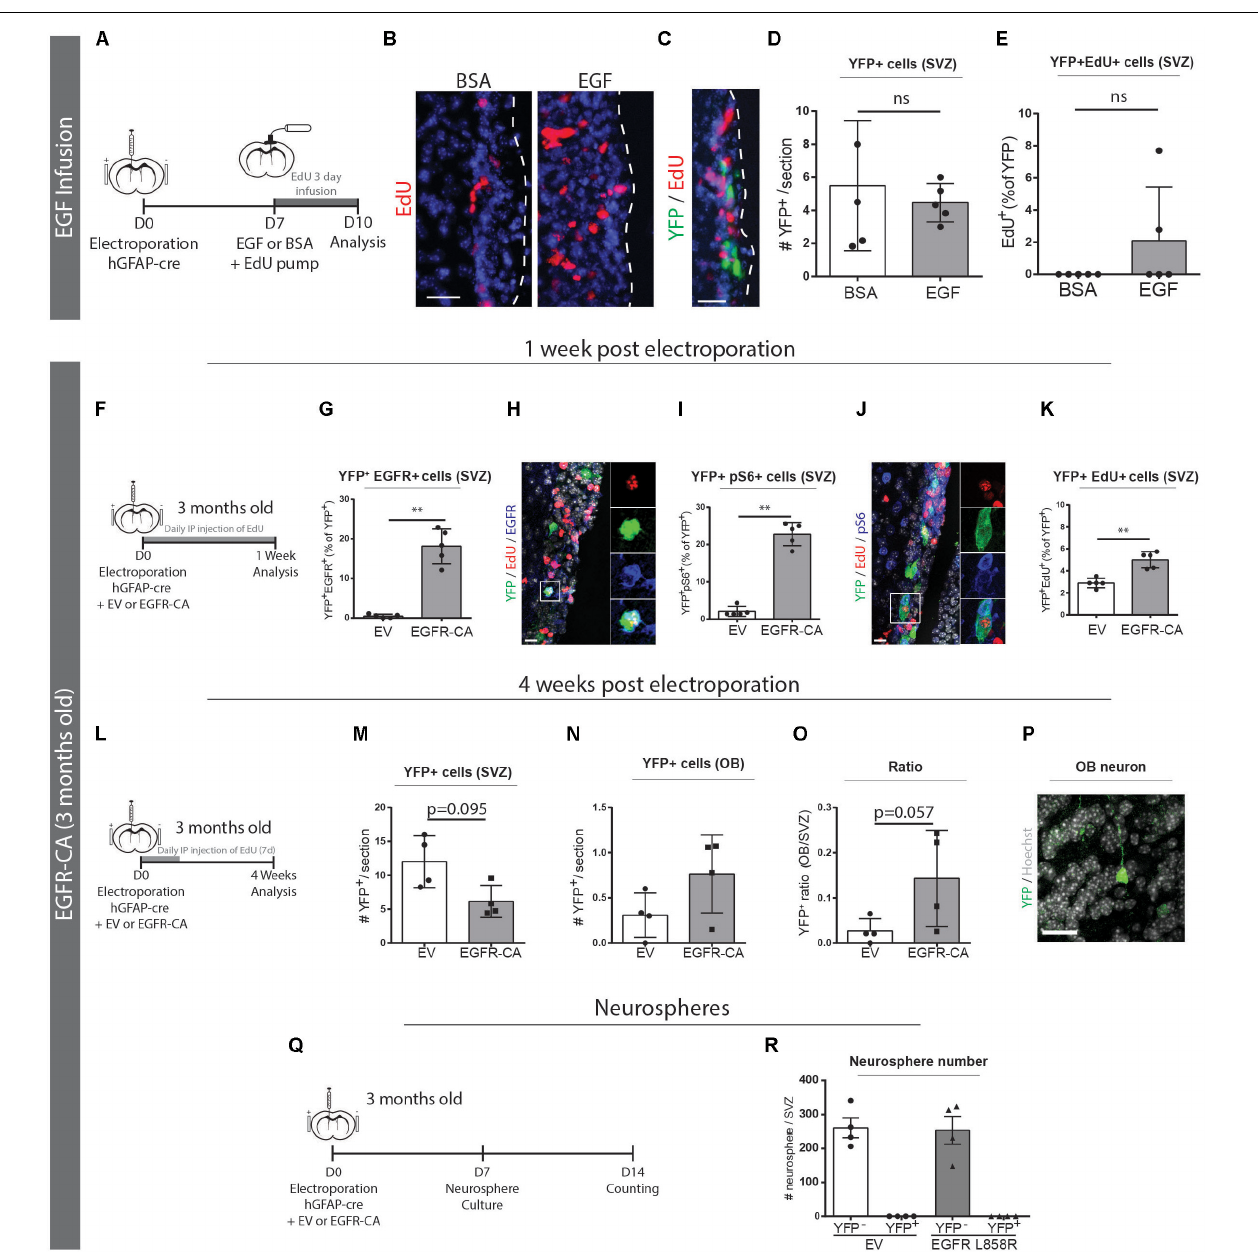
FIGURE 4 | Genetic activation of EGFR signaling can promote qNSC division in vivo . (A–E) Electroporated GFAP + qNSCs do not divide in response to EGF infusion. (A) Paradigm for adult brain electroporation with hGFAP-cre plasmids in Rosa26-stop-EYFP reporter mice followed by 3 days infusion of EdU with either EGF or BSA via intracerebroventricular osmotic pump. (B) Representative micrographs of EdU incorporation in the V-SVZ following 3 days infusion of EGF ( n = 3) or BSA ( n = 3). (C) Representative micrograph and quantifications of (D) total YFP + cells and (E) YFP + EdU + cells in the V-SVZ. Neither YFP + cells nor YFP + EdU + dividing cells increased in response to EGF infusion. (F–Q) EGFR-CA electroporation in 3-month-old mice Rosa26-stop-EYFP mice and tissue analysis after 1-week (F–K) , 4-weeks (L–O) , or by neurosphere analysis (P,Q) . (F) 1-week paradigm for adult brain electroporation with hGFAP-cre plasmids, mixed with either EV or EGFR-CA plasmids, in Rosa26-stop-EYFP reporter mice. (G–K) Quantifications of the proportions of recombined (YFP+) cells that (G) express EGFR protein, (I) activate downstream pS6 signaling, and (K) incorporate EdU ( n = 5/group). Shown are representative micrographs of (H) YFP/EdU/EGFR and (J) YFP/EdU/pS6 immunostainings. (L) 4-week paradigm for adult brain electroporation with hGFAP-cre plasmids, mixed with either EV or EGFR-CA plasmids, in Rosa26-stop-EYFP reporter mice. (M–O) 4 weeks post-electroporation, quantifications show trends for (M) a depletion of YFP + cells in the V-SVZ, (N) an increase in YFP + cells in the OB, and (O) a consequent increase in the OB/V-SVZ ratio ( n = 4/group), and (P) a representative micrograph of YFP + cell in the OB. (Q) Neurosphere formation paradigm for adult brain electroporation with hGFAP-cre plasmids, mixed with either EV or EGFR-CA plasmids, in Rosa26-stop-EYFP reporter mice. (R) Quantification of the number of YFP + and YFP- neurospheres produced after 1 month of neurosphere culturing. Note that EGFR-CA electroporation increased qNSC division but did not yield any aNSC-associated recombined neurospheres. Scale bars represent 50 µ m in (B,C) , and 20 µ m in (H,J) and 30 µ m in (P) . Mann–Whitney test, ∗∗ p =